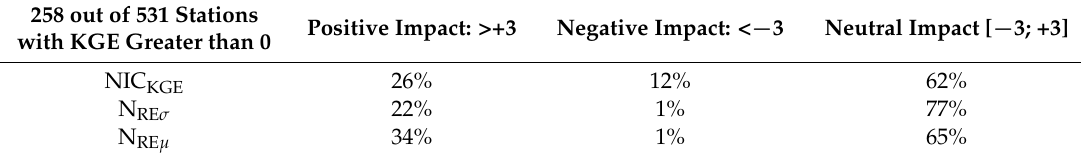
Table 4. Analysis impact evaluation against daily streamflow over 2010–2016. The impact from the analysis with respect to the model is assessed through the normalized information contribution (NIC) applied to the Kling–Gupta efficiency (KGE) score, as well as using normalized relative error of simulated or analysed mean (RE μ ) and standard deviation (RE σ ). Scores are classified according to three categories: (i) negative impact from the analysis with respect to the model with values smaller than − 3, (ii) positive impact from the analysis with respect to the model with values greater than +3, and (iii) neutral impact from the analysis with respect to the model with values between − 3 and 3.